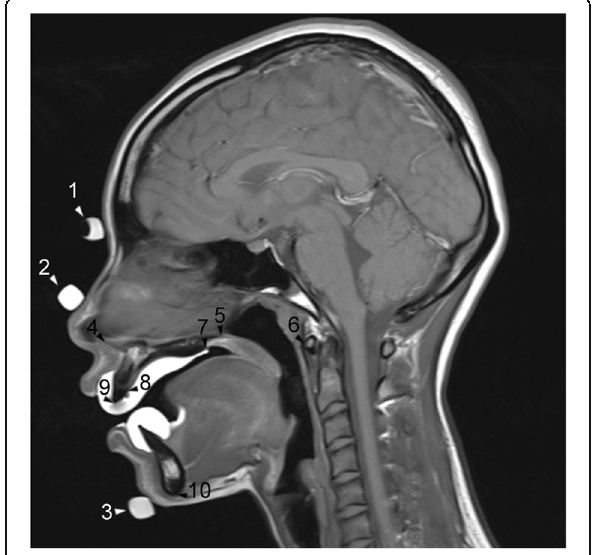
Fig. 3 A representative static magnetic resonance image. Landmarks on the (1) forehead, (2) nasal tip, (3) chin, (4) ANS (anterior nasal spine), (5) PNS (posterior nasal spine), (6) C1 (the most anterior point of the atlas), (7) PM (point at which the soft and hard palates intersect), (8) AM (boundary point between the maxillary central incisor and the palatal mucosa), (9) I (point at the edge of the maxillary incisor), and (10) Me (the most posterior point on the mandibular symphysis).